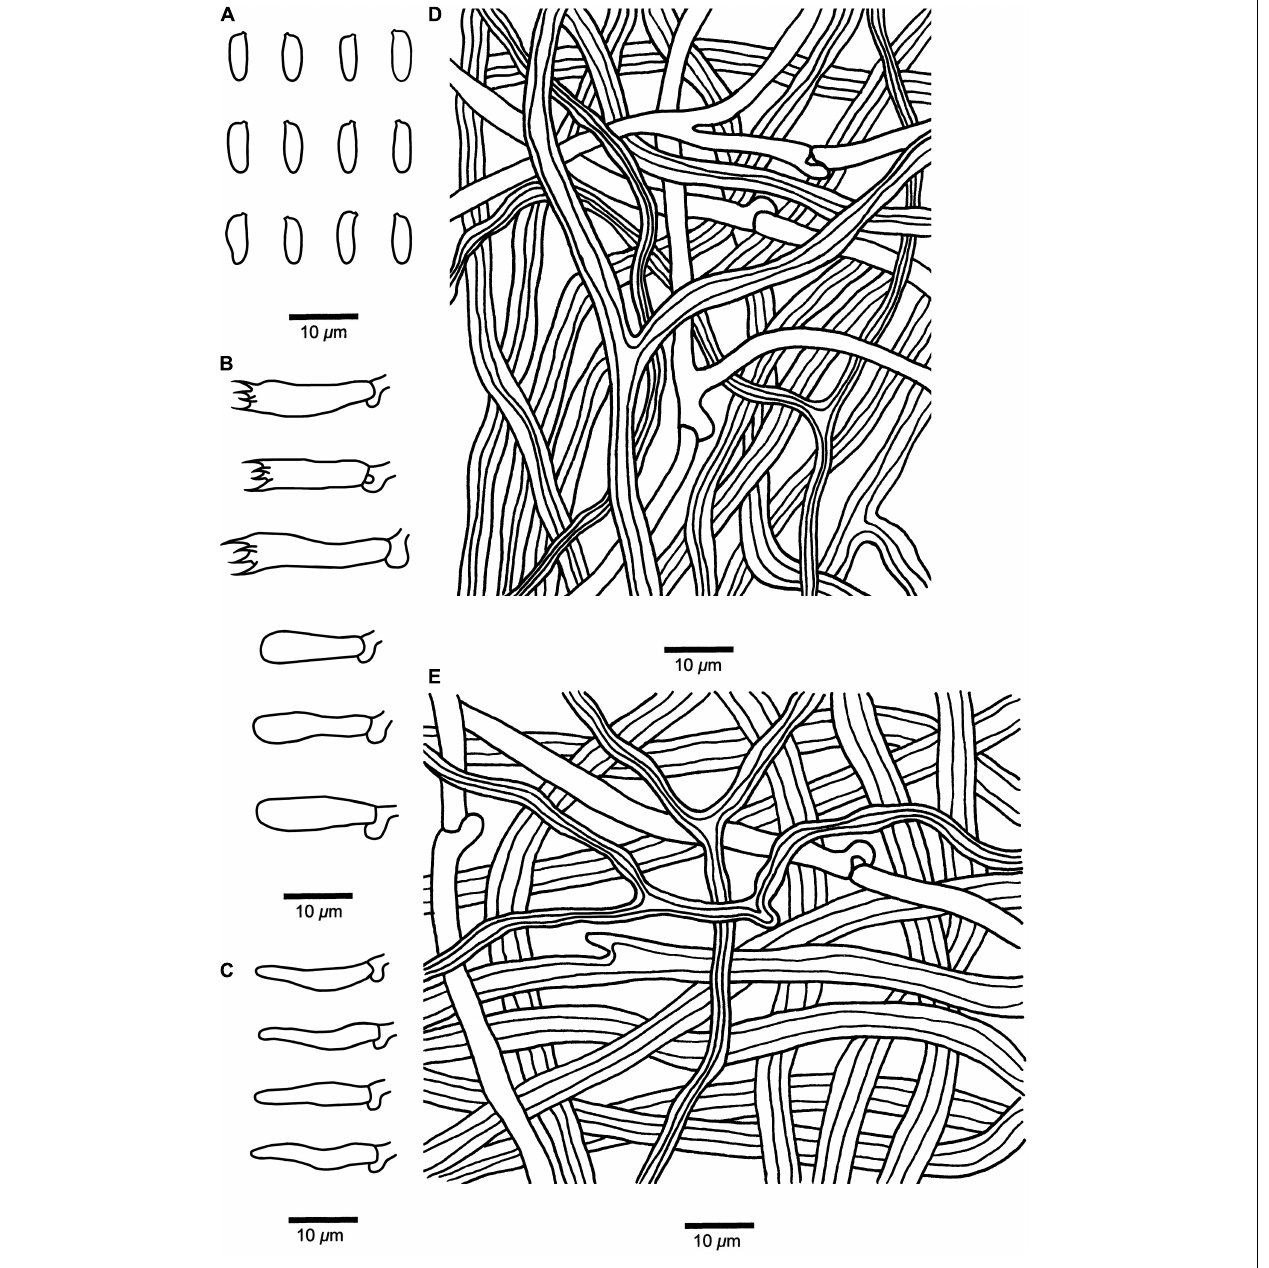
FIGURE 4 | Microscopic structures of Fomitopsis srilankensis (Holotype, Dai 19539 ). (A) Basidiospores. (B) Basidia and basidioles. (C) Cystidioles. (D) Hyphae from trama. (E) Hyphae from context. Drawings by: Shun Liu.